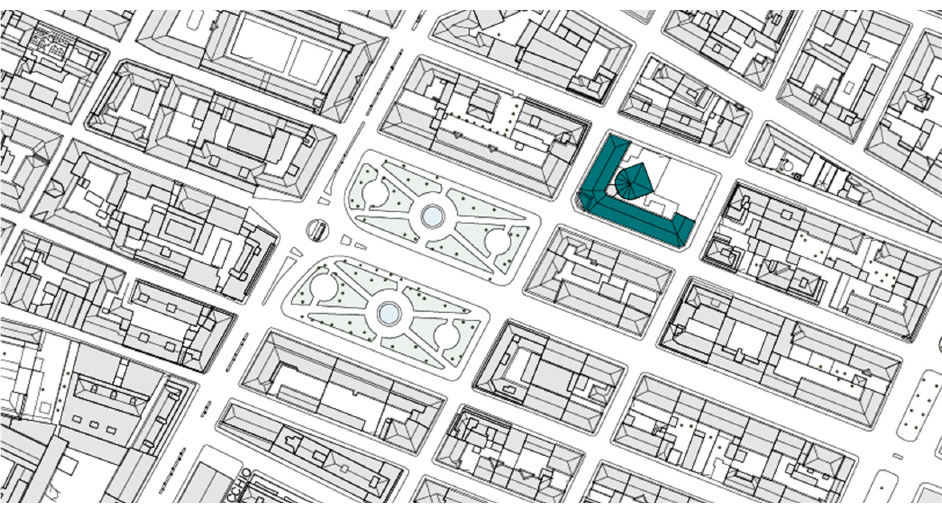
Figure 10. The technical map of Piazza Genova gives a more precise idea of the present configuration of the square; it is divided into two mirrored small parks, with two central fountains, introduced by the Arch of Marengo on the Western side and connected to the building of the high school Liceo Classico “Giovanni Plana” (in blue); in particular, the distribution of the trees follows a circular path around the central points of the parks, marking the ideal axis that reconnects the two fountains [Source: Municipality of